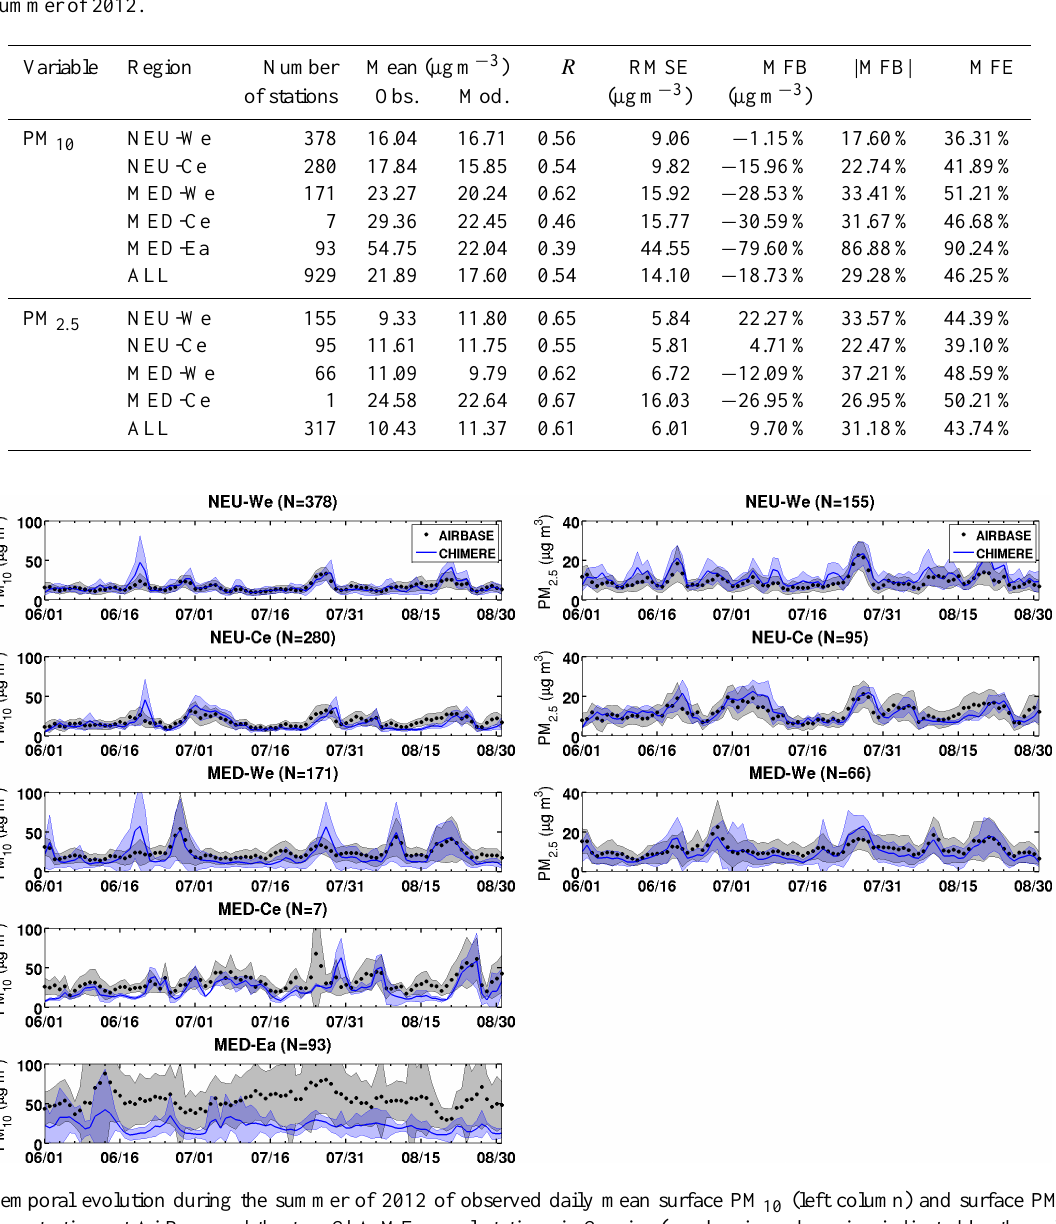
Table 3. Performance statistics for the simulation of daily PM with CHIMERE (Mod.) compared to coincident station measurements (Obs.) during the summer of 2012.